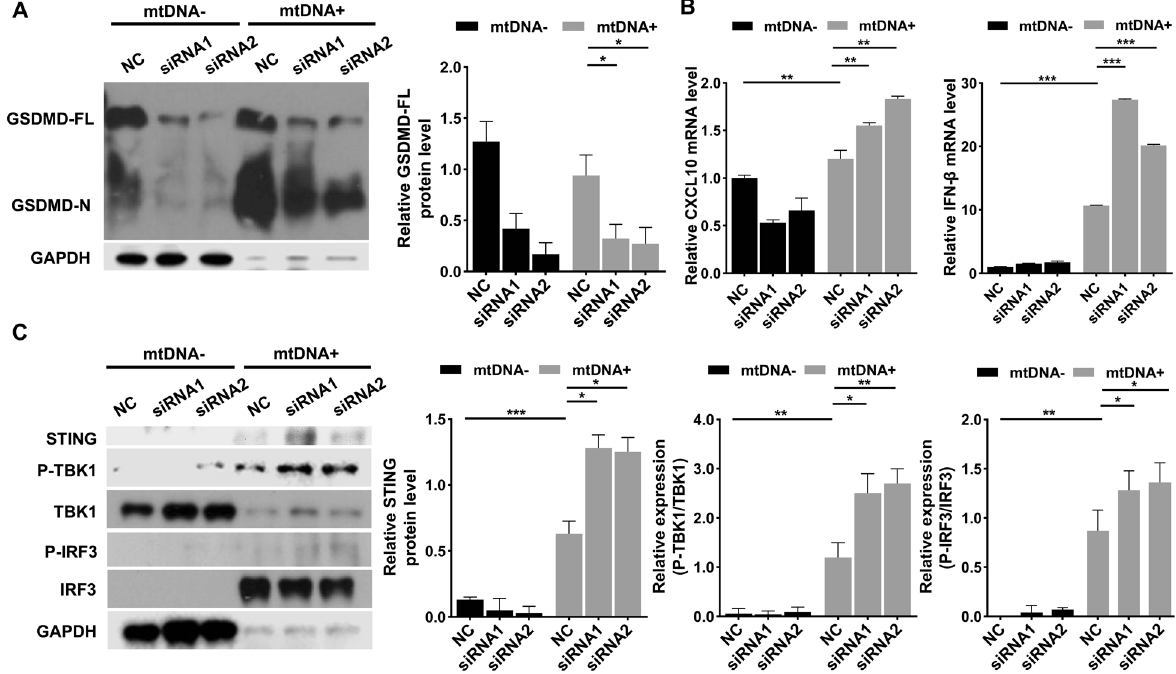
Fig. 5 Cytosolic mtDNA activated the STING pathway after GSDMD knockdown. A In an interval 48 h, anti-GSDMD siRNA was transfected mDPC6T cells twice, after the second transfection mtDNA overexpressed. B The mRNA level of CXCL10 and IFN- β in mDPC6T cells was assessed by qPCR with or without GSDMD knockdown in response to 24 h of mtDNA transfection. C The protein expression of STING, P-TBK1/ TBK1, P-IRF3/IRF3 was analyzed by western blotting with or without GSDMD knockdown in response to 24 h of mtDNA transfection. The data are the means ± standard deviations of 3 independent experiments ( p < 0.05 * , p < 0.01 ** , p < 0.001 ***